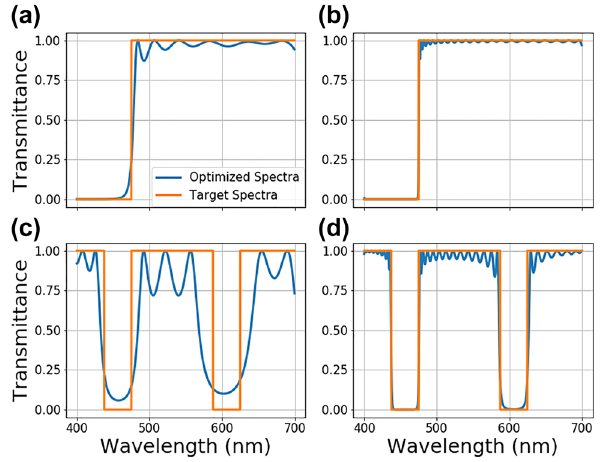
Figure 4: Transmittance spectra comparison between the target spectra (orange) and the generated optimized optical stack spectra (blue) for a long pass filter with a cut-on at 475 nm for (a) 50, and (b) 200-layer structures. The same plots are shown for a dual stop band filter with stop ranges between 437.5 and 475 nm and 587.5–625 nm for (d) 50, and (e) 200-layer